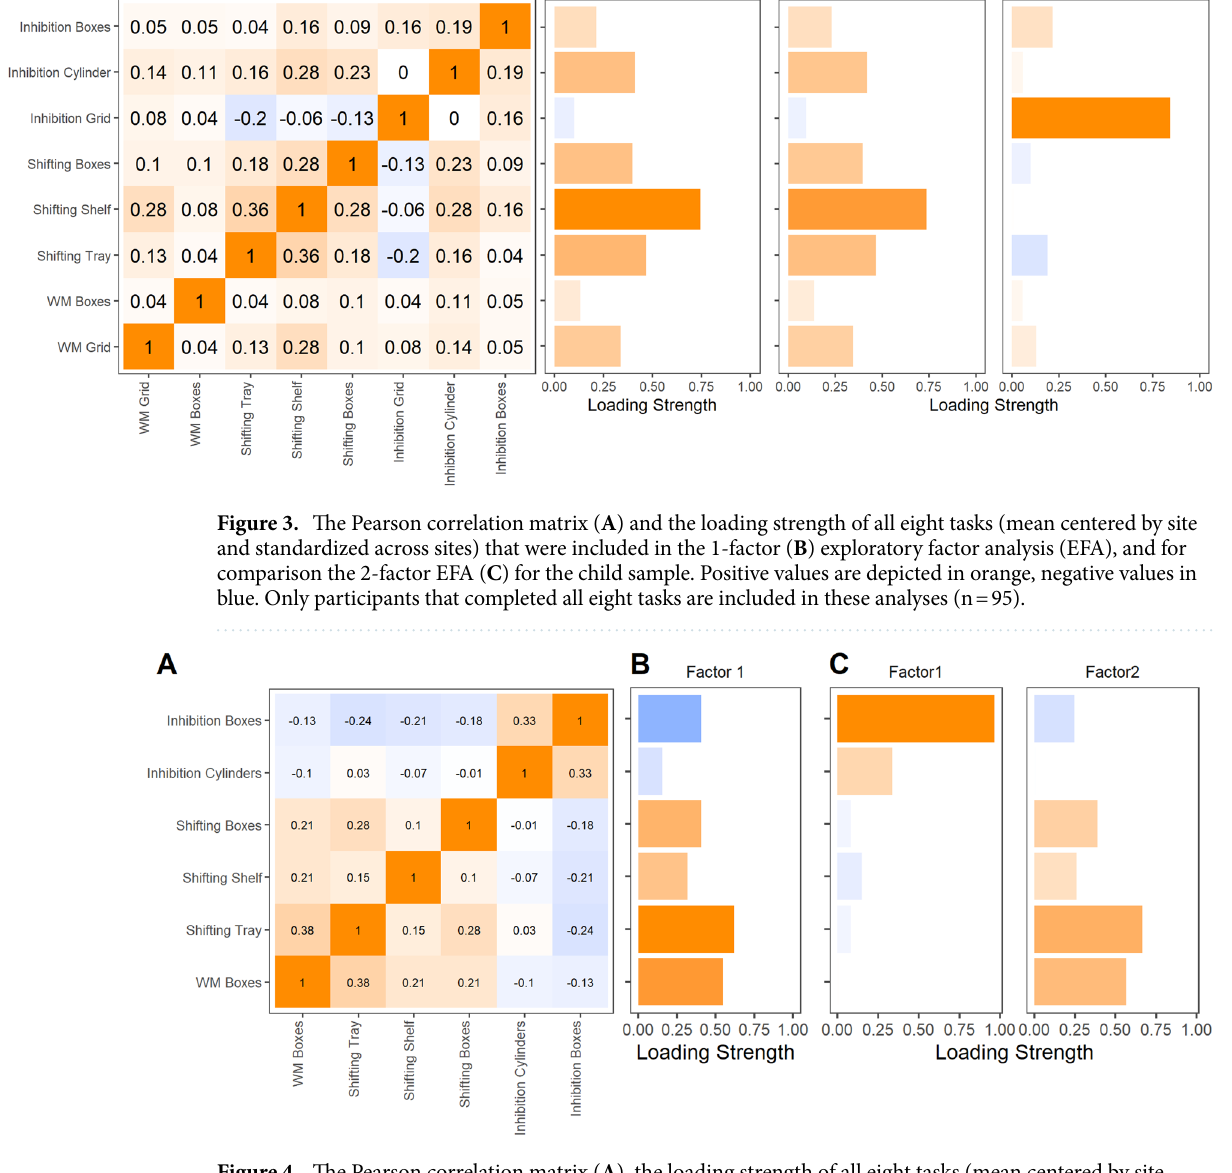
Figure 4. The Pearson correlation matrix ( A ), the loading strength of all eight tasks (mean centered by site and standardized across sites) that were included in the 1-factor ( B ) exploratory factor analysis (EFA), and for comparison the 2-factor EFA ( C ) for the chimpanzee sample. Positive values are depicted in orange, negative values in blue. Only subjects that completed all six tasks are included in these analyses (n =